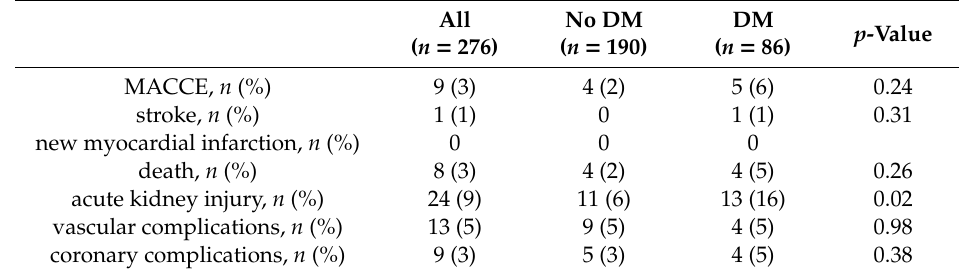
Table 3. In-hospital major adverse cardiac and cerebrovascular (MACCEs) and adverse events.